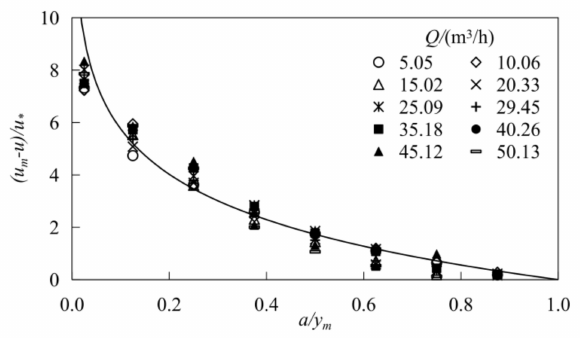
Figure 5. Theoretical curve and experimental data in the clear water pipe.